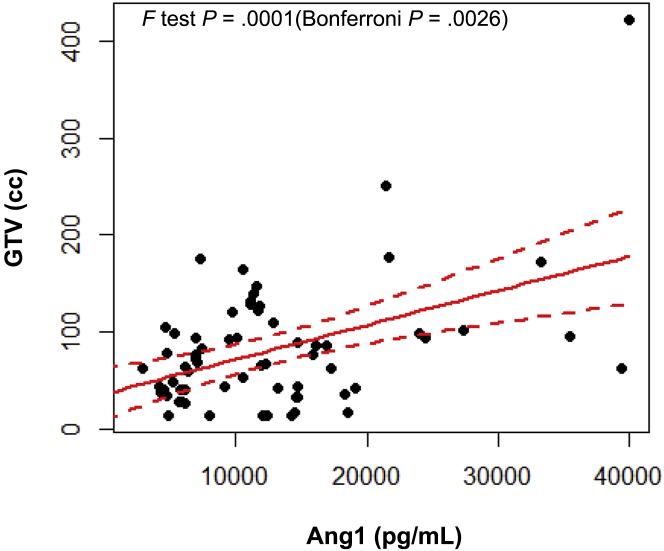
Correlation Between Baseline Angioprotein (Ang)-1 and Gross Target Volume (GTV; Solid Red Line) With 95% CI (Red Dashed Lines)